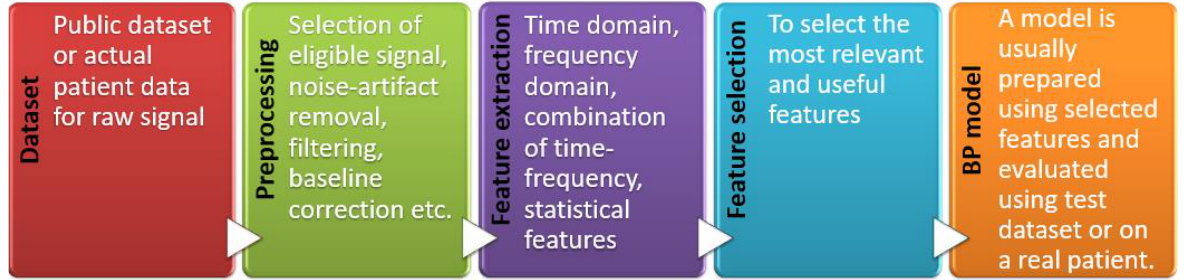
Figure 6. Typical steps for pulse wave analysis to get BP measurement model.